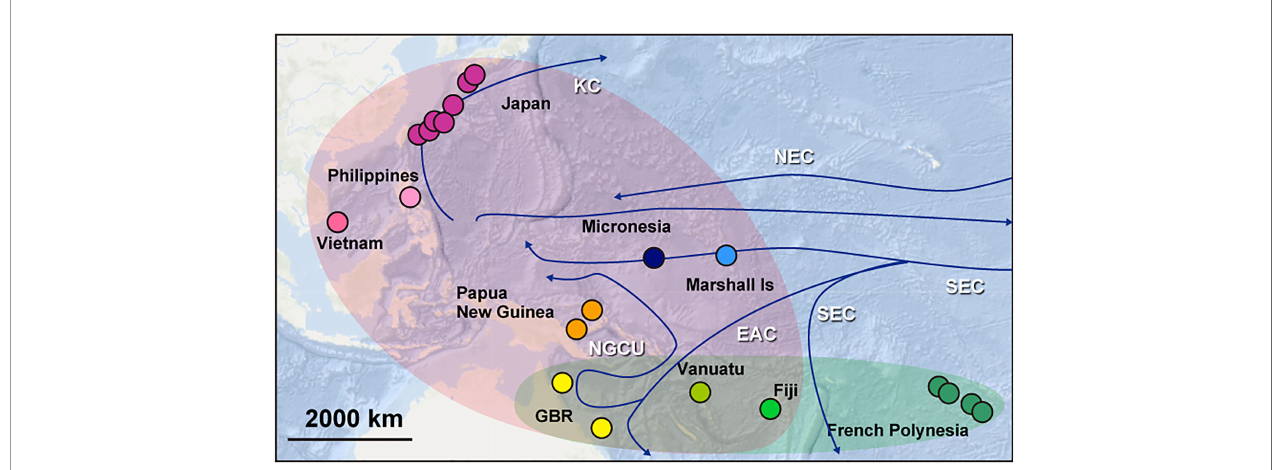
FIGURE 6 | A summary diagram to show a possible historical colonization of COTS with main seawater currents in the Paci fi c. The Paci fi c hosts two major groups of COTS. The East-Central Paci fi c group comprises COTS from French Polynesia, Fiji, Vanuatu, and the GBR (blue). The Pan Paci fi c group contains COTS from the entire Western Paci fi c (purple). Blue arrows show the main currents in the Paci fi c Ocean. KC, Kuroshio Current; CC, California Current; NEC, North Equatorial Current; ECC, Equatorial Countercurrent; SEC, South Equatorial Current; EAC, East Australian Current and NGCU, New Guinea Coastal